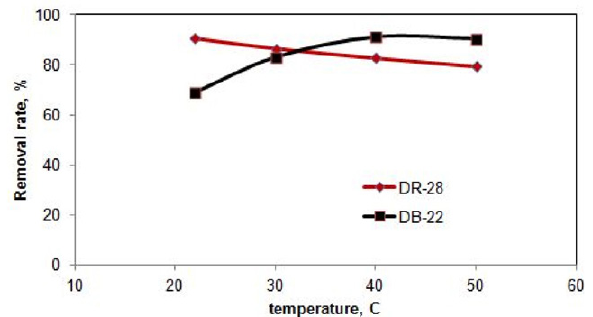
Fig. 8. Effect of temperature on the removal of DR-28 and DB-22 (pH: original, initial concentration: 30 mg/L, adsorbent: KZF, ad- sorbent amount: 1g/200mL, contact time: 60